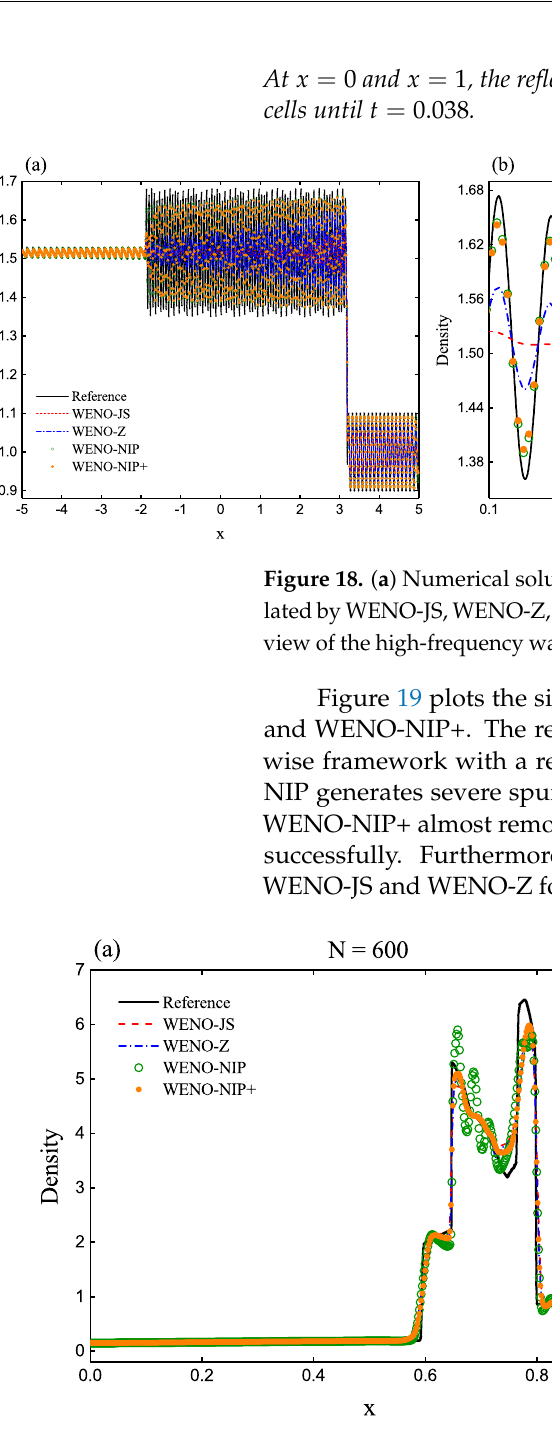
Figure 19. ( a ) Numerical solutions of the interacting blast wave problem calculated by WENO-JS, WENO-Z, WENO-NIP, and WENO-NIP+ in component-wise framework at t = 0.038 with N = 600. ( b ) Zoomed-in view of the interacting